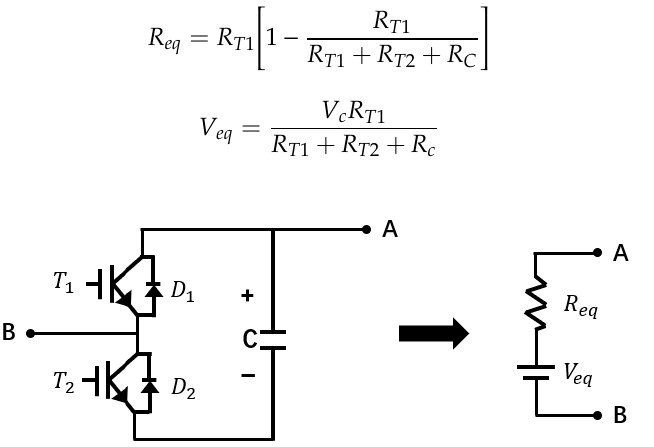
Figure 2. Thevenin equivalent circuit of submodules.